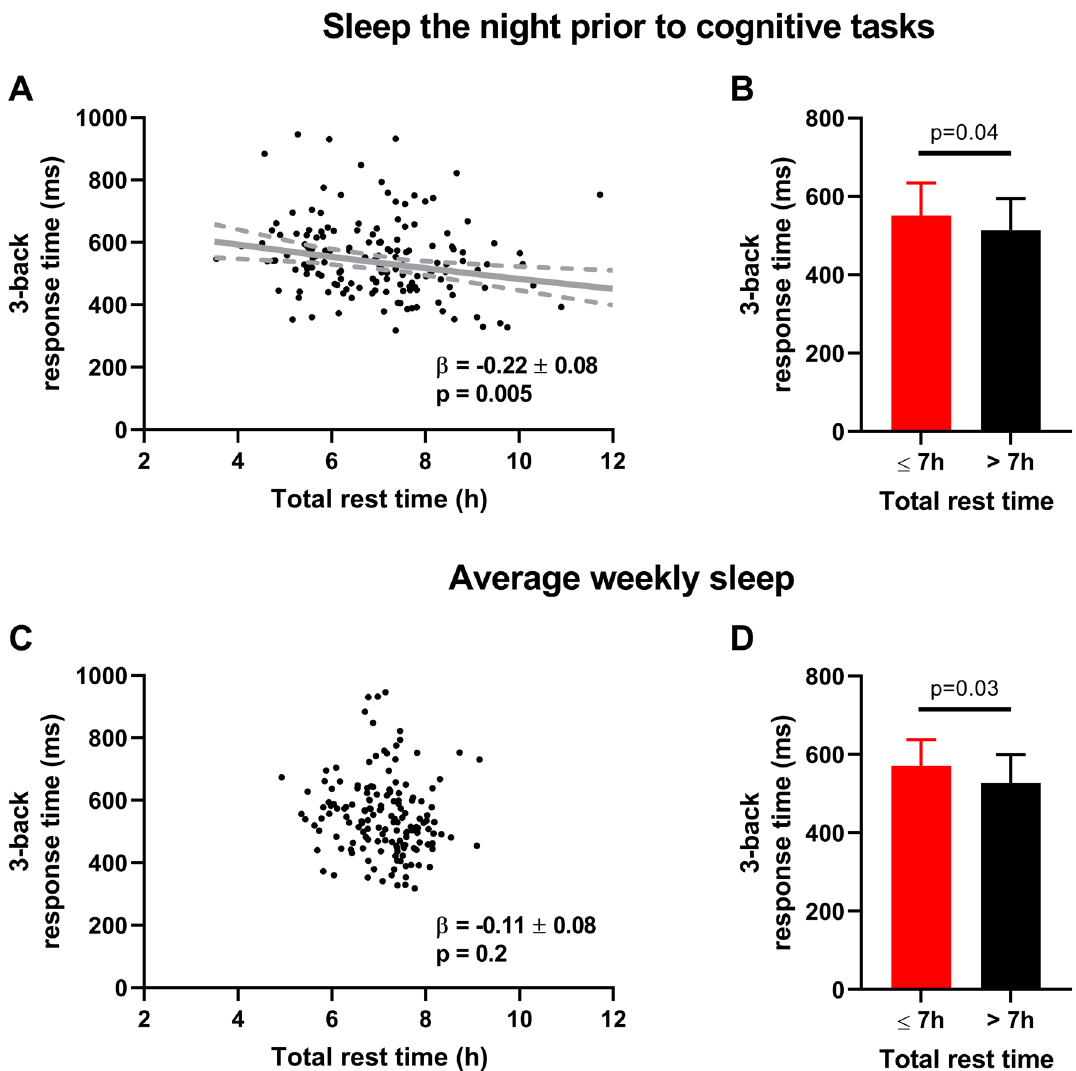
Figure 1. Relationship between response time on the most difficult (3-back) work memory load and total rest time. ( A ) The solid grey line demonstrates the inverse correlation between total rest times the night prior to the cognitive task and 3-back response times. Broken grey lines indicate the 95% confidence intervals. ( B ) Participants with 7 h or less total rest time (in red, N = 82) had longer response times than those with greater than 7 h (in black, N = 78). ( C ) Average weekly total rest time did not correlate with 3-back response times. ( D ) Participants that average 7 h or less daily total rest time over the week (N = 66) had longer response times than those that averaged greater than 7 h (N = 94). All comparisons adjusted for clinical diagnosis of attention deficit hyperactivity disorder, reported weekly video game use, and 1-back response times. Response times were log-transformed prior to analysis due to skewed distributions; inverse transformation was applied for displayed in ( A ); bars and error bars in ( B ) and ( D ) are medians and interquartile ranges. β, standardized beta ± standard